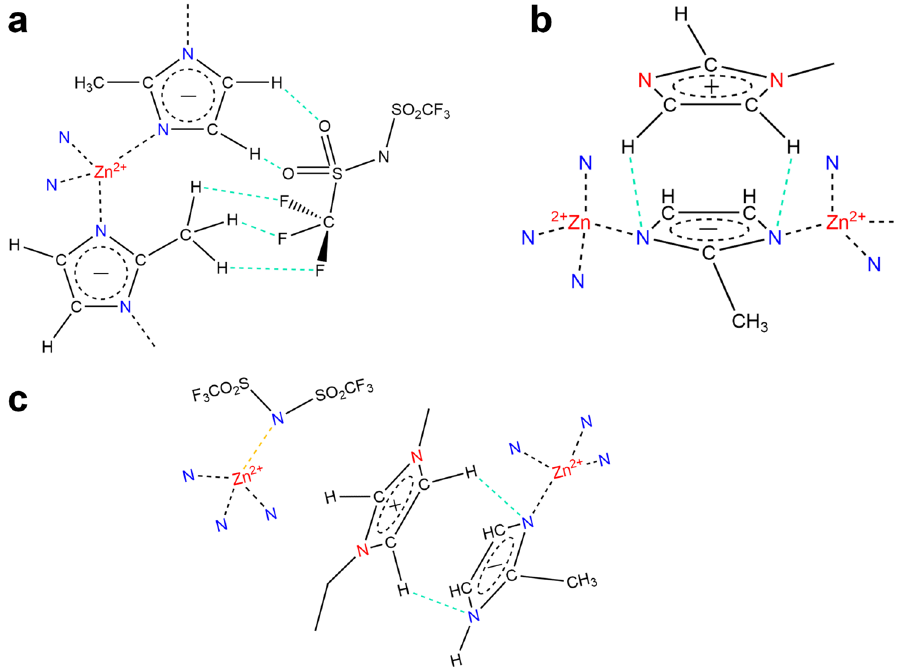
Fig. 6 2D schematic of possible interactions between IL and ZIF-8. a Interactions with the IL anion; b Interactions with the IL cation. c Melting/ amorphization of IL@ZIF-8 at 381 °C. Orange and green bonds represent Zn 2 + – N − bonding and H bonding between IL and ZIF-8, respectively. For a schematic view of the whole pore, see Supplementary Fig.